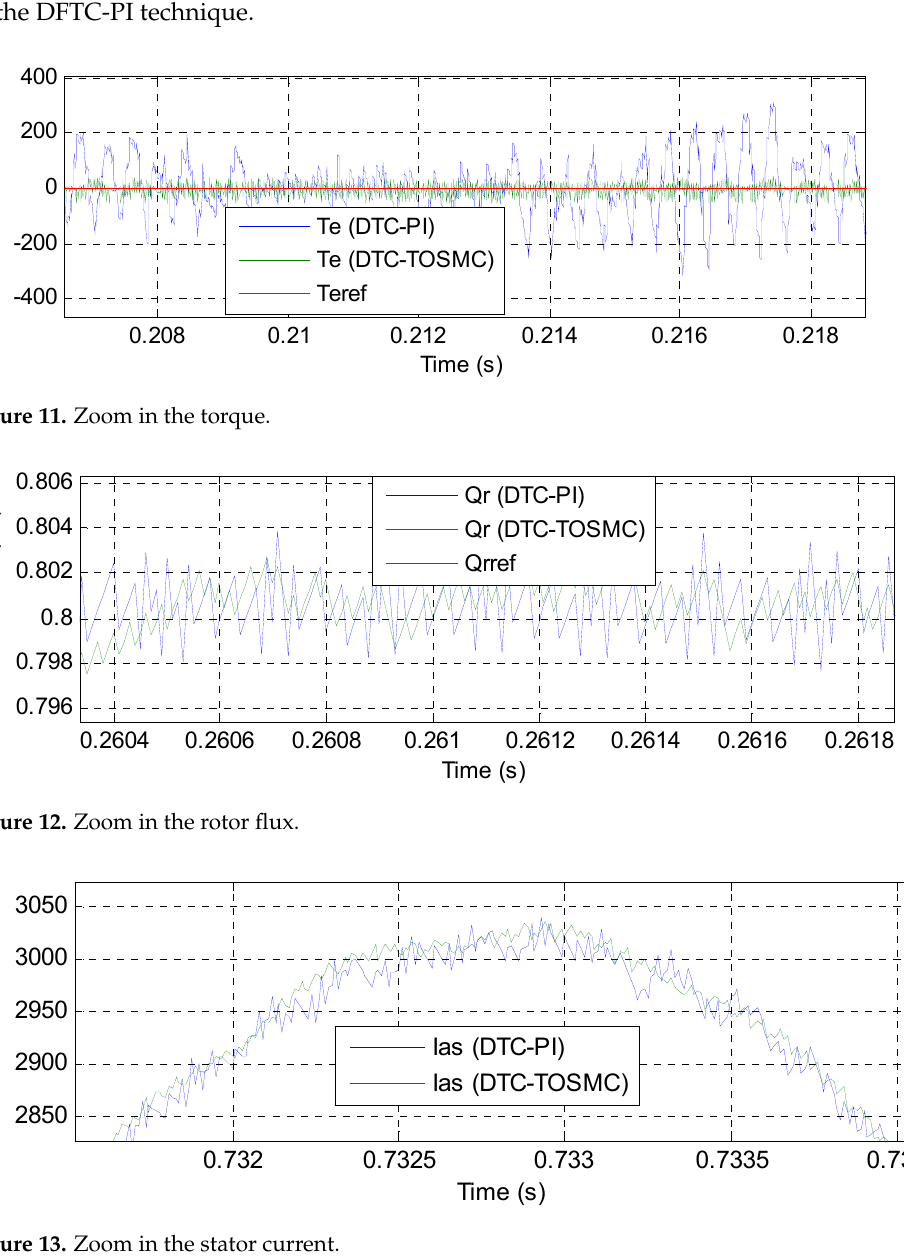
Table 1. Comparison of the THD values obtained from the proposed method with values from sev- eral published methods.